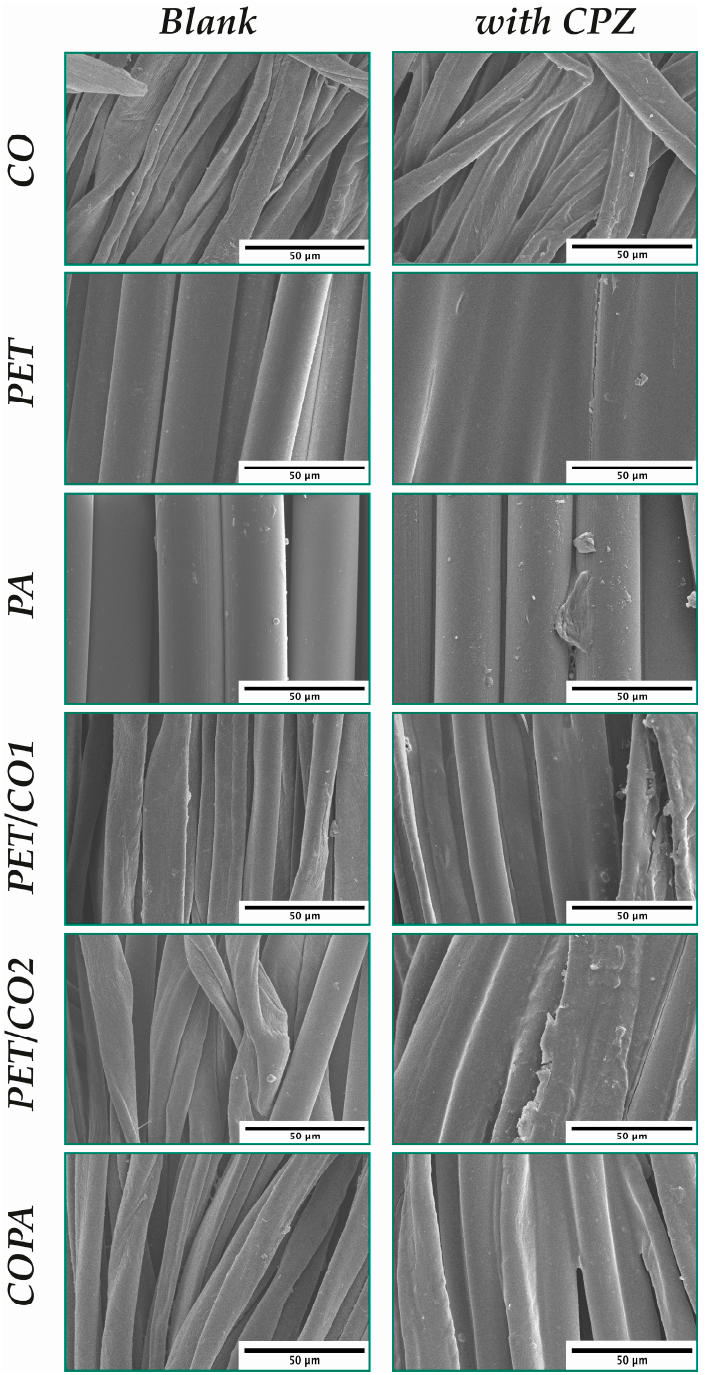
Figure 3. SEM micrographs of the original textile ( left ), textile finished with CPZ after one washing cycle ( right